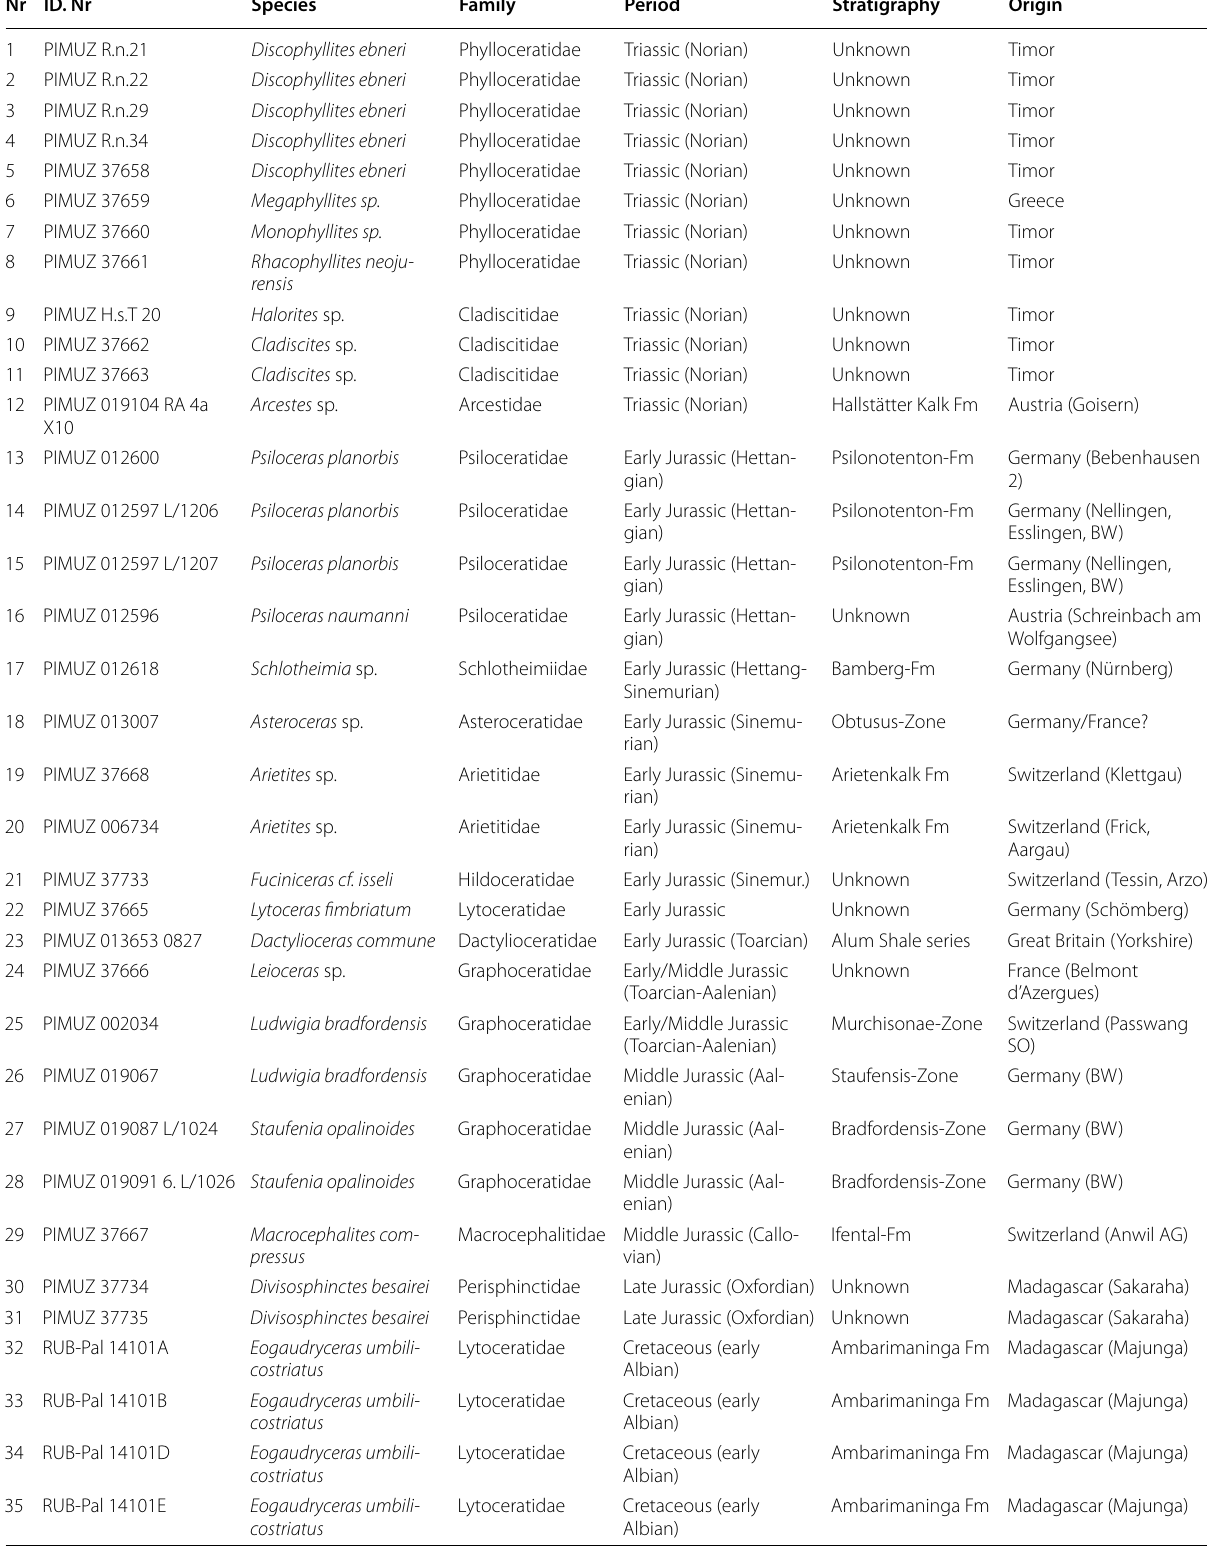
Table 1 Catalogue of all specimens used in this